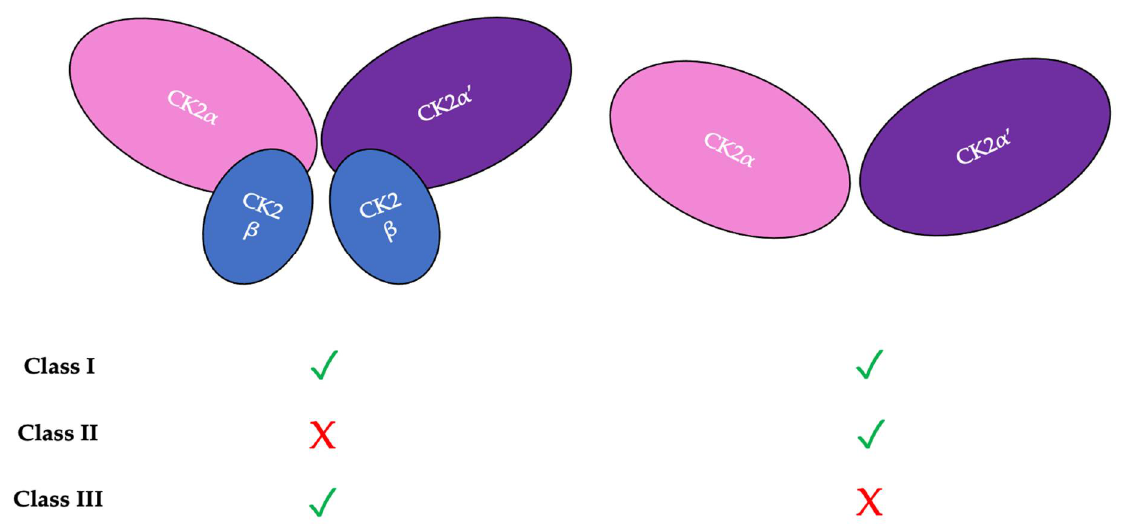
Figure 2. There are three classifications of CK2 substrates. Class I substrates are identified as pro- teins that are equally phosphorylated by the holoenzyme and individually by the catalytic subunits. Class II substrates are specifically phosphorylated by the catalytic submits of CK2 but not by the holoenzyme. Class III substrates are preferentially targeted and phosphorylated by the holoenzyme but not by the catalytic subunits of